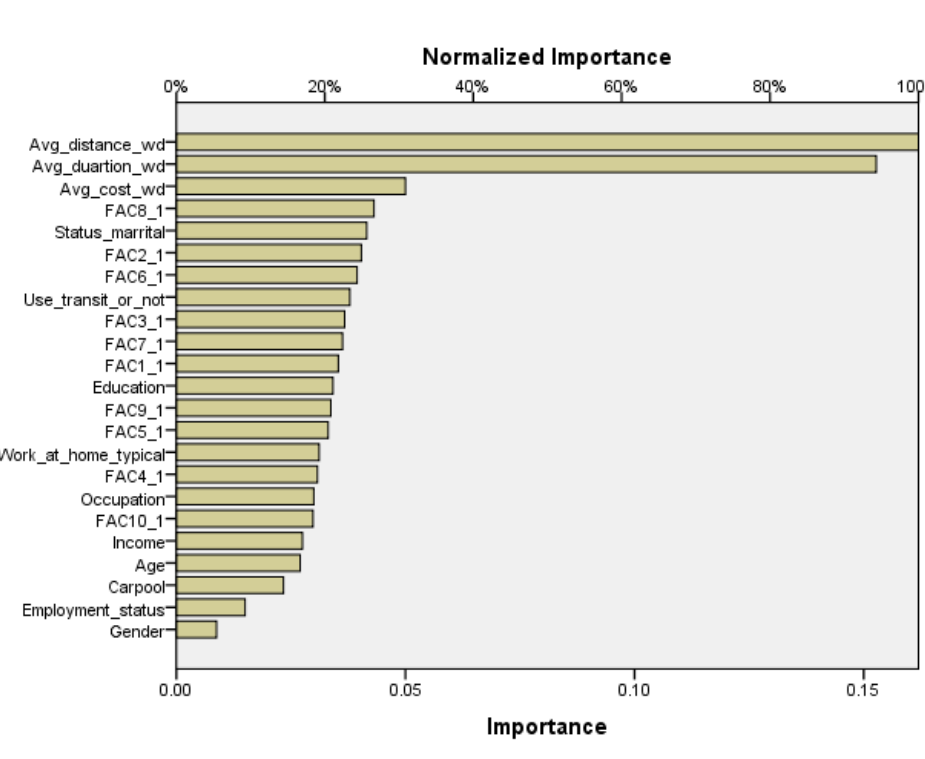
Table 14. Model Summary.